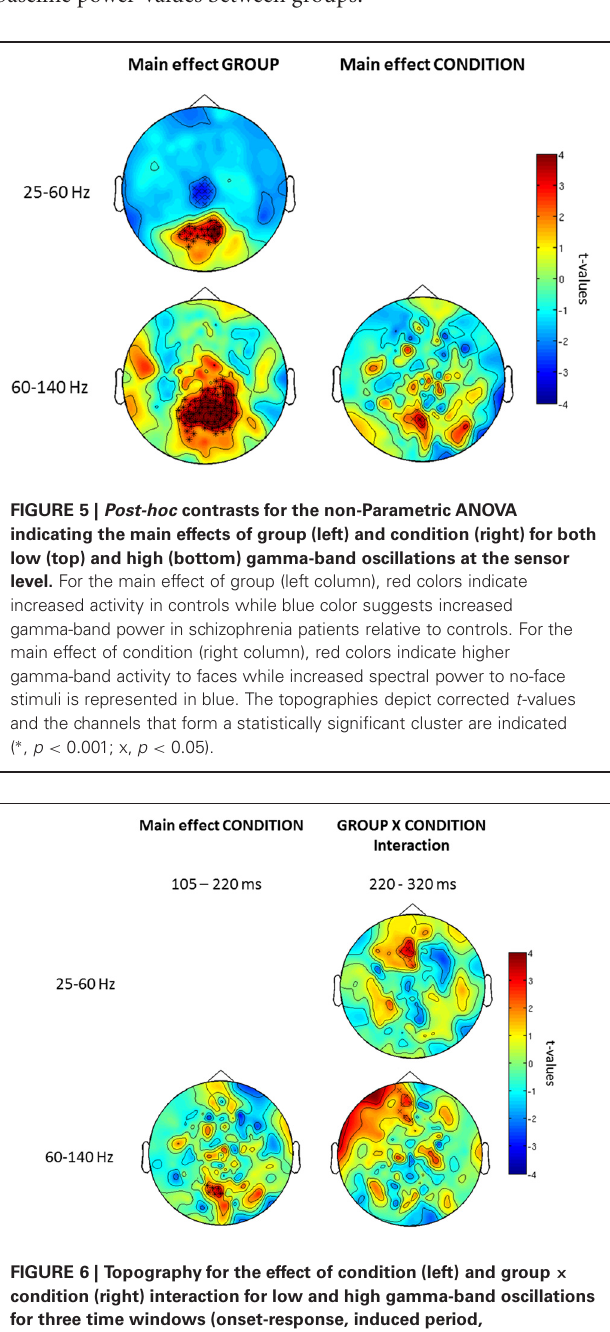
FIGURE 7 | Correlation between high gamma-band power and disorganization. The scatter-plot shows the relationship between high (60–120Hz) gamma-band power in the 50–350ms time window over positive channels and the disorganization component of the